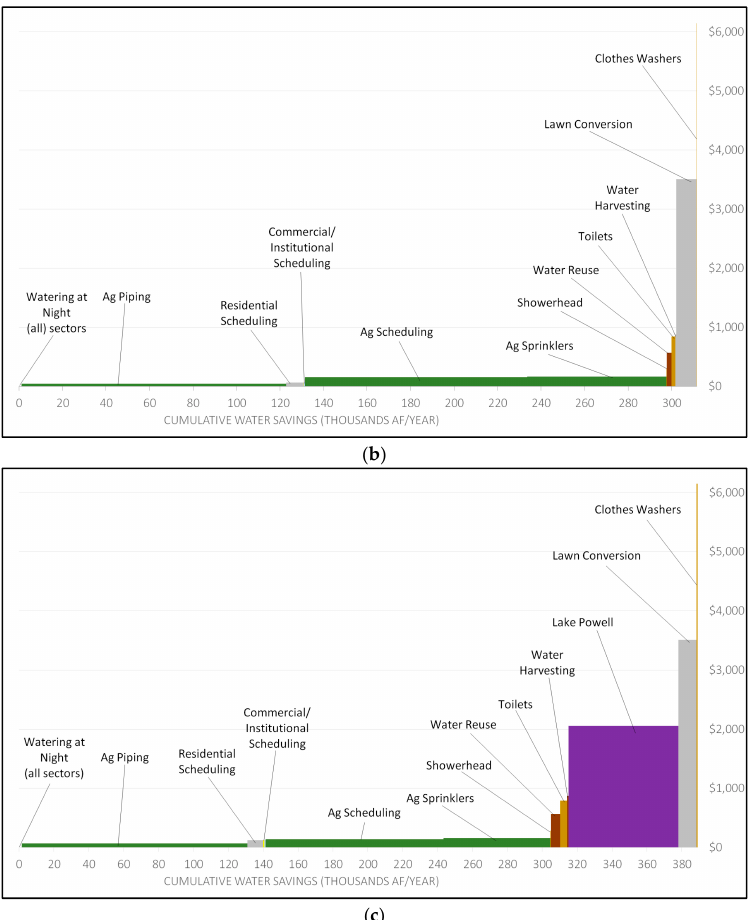
Figure 4. Water efficiency supply curves for Utah’s regions: ( a ) northern Utah; ( b ) eastern Utah; ( c ) southwestern Utah. ( c ) southwestern